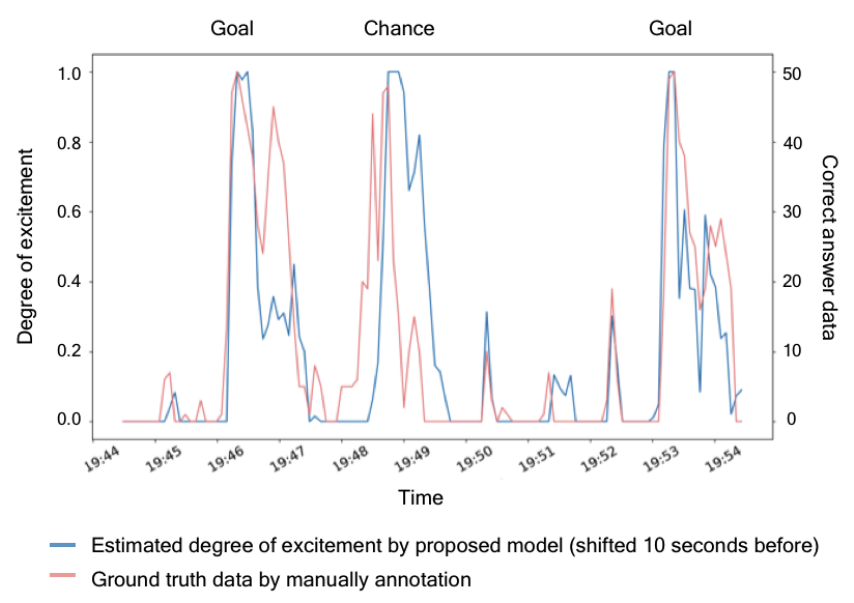
Figure 4. Estimated degree of excitement (blue lines) and the ground truth (pink lines) after a 10 s shift.